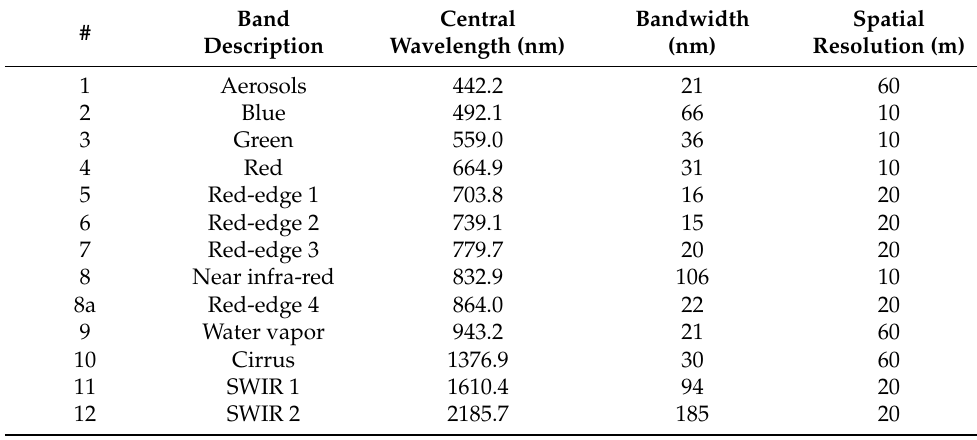
Table 2. Sentinel 2B sensor’s spectral and spatial resolutions